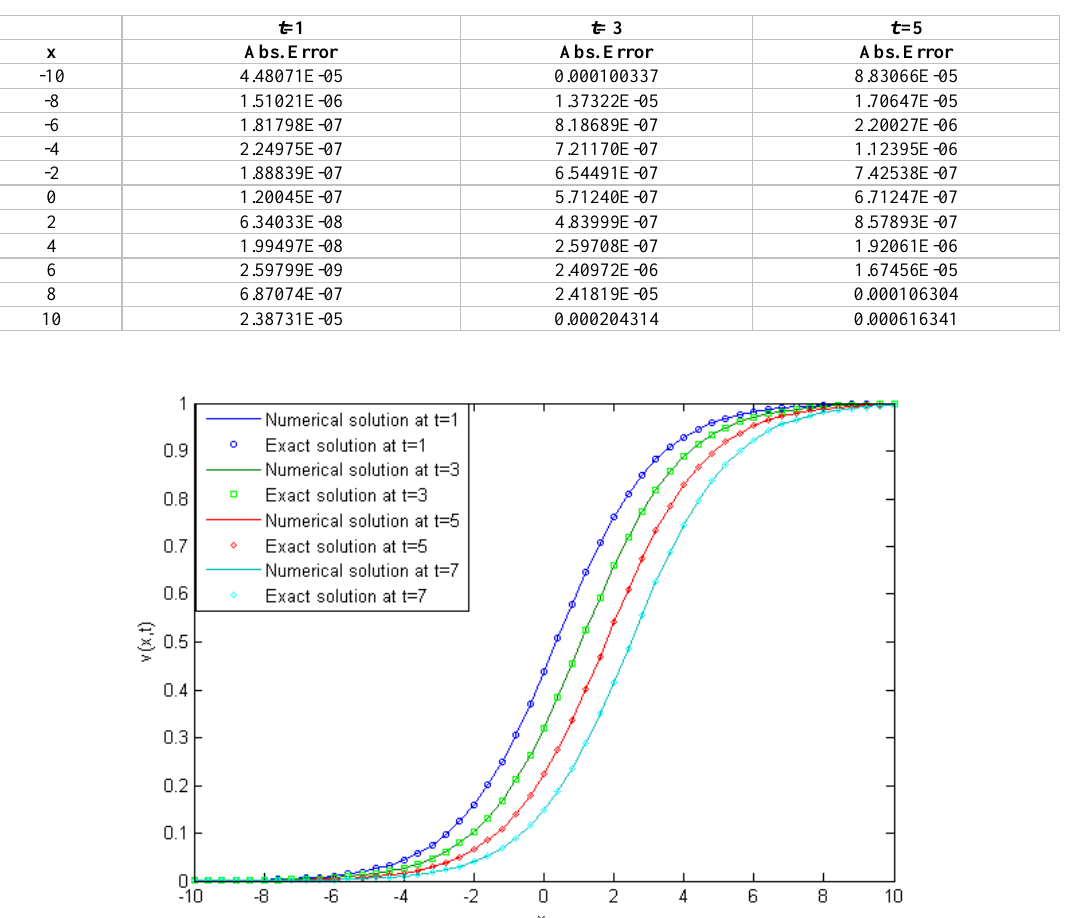
Figure 1. Comparison of results of Example 1 for different levels of time